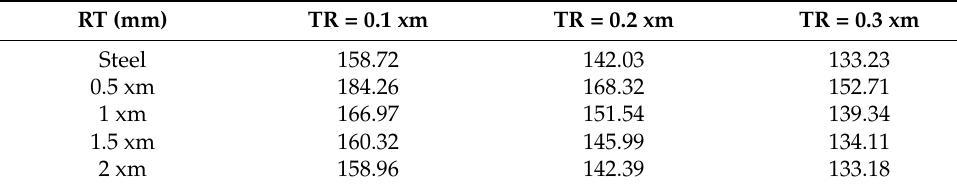
Table 5. Root stress (N/mm 2 ) results of hybrid and steel